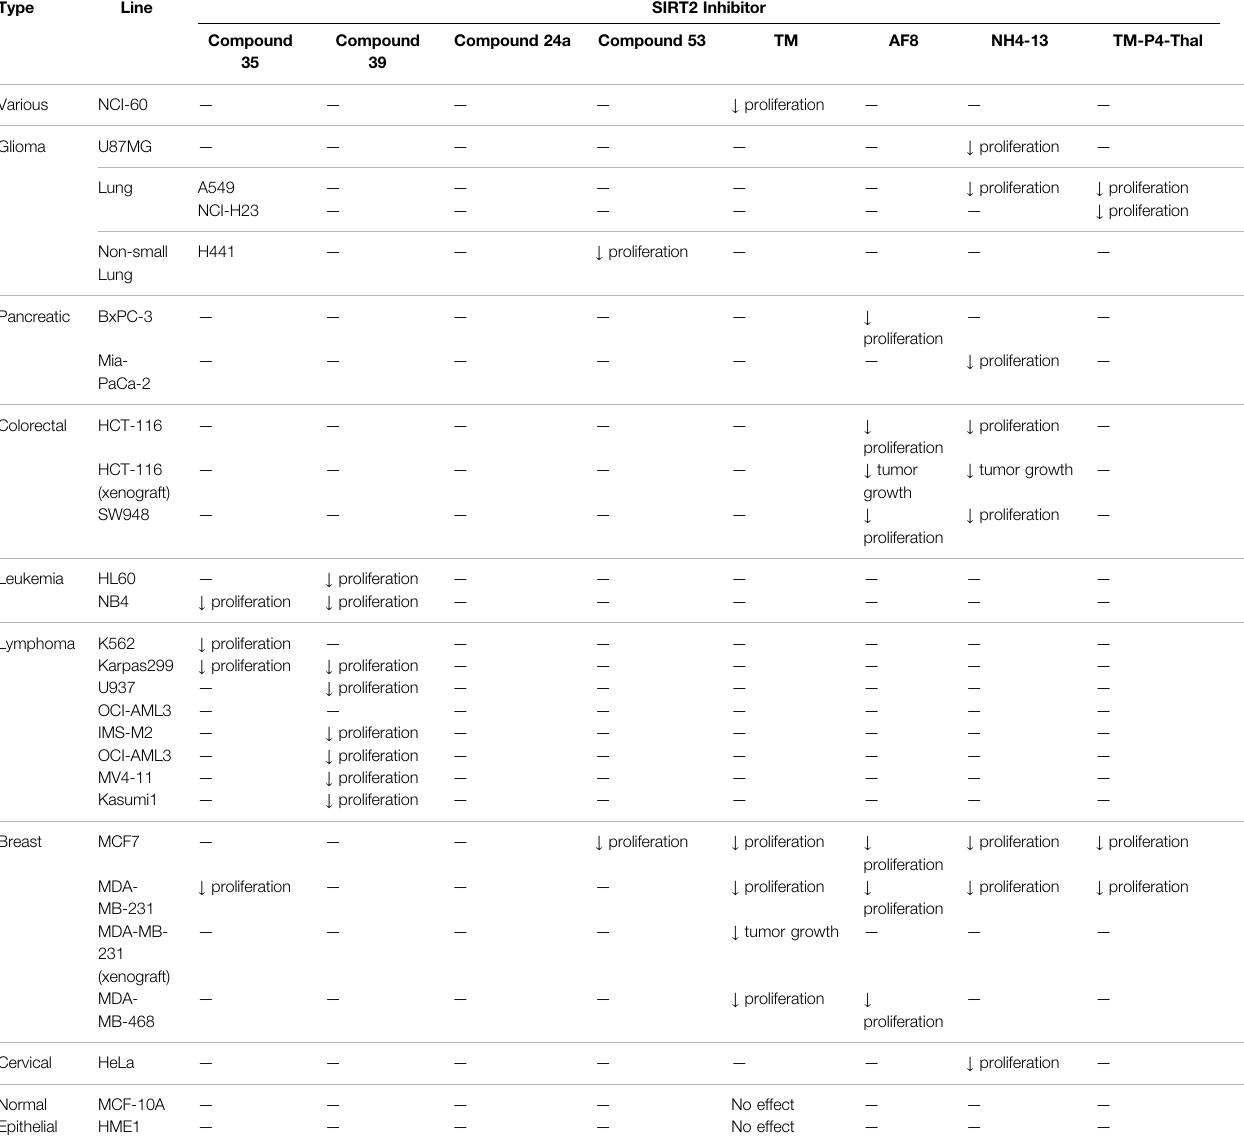
TABLE 4 | Cell lines affected by SIRT2 Inhibitors (#2 set). Type Line